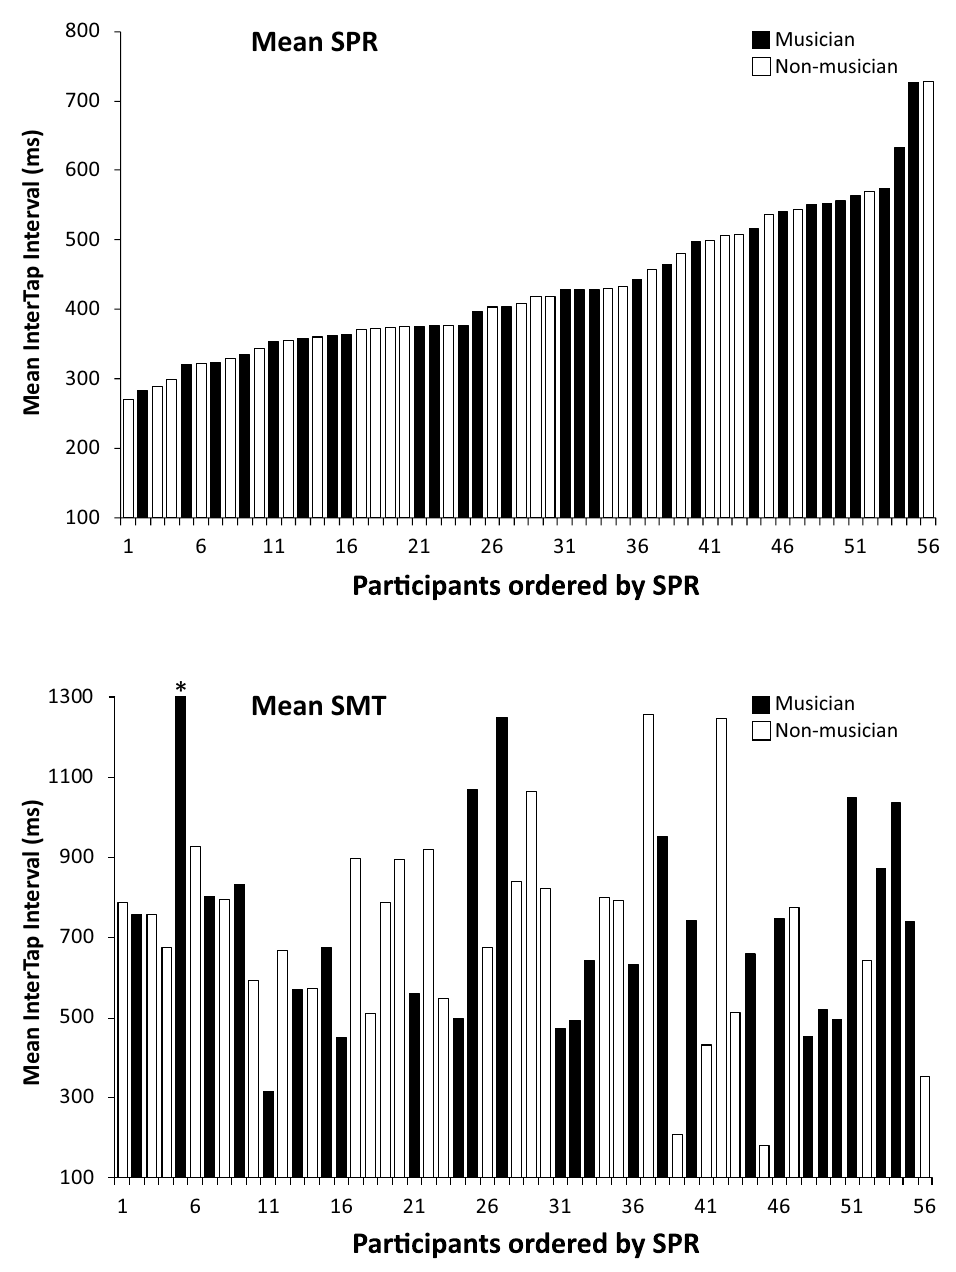
Figure 1. Mean Intertap interval in Solo production rate (SPR) task (top) and SMT task (bottom). Participants ordered left to right by increasing SPR value (top and bottom). Each bar represents one participant. Asterisk indicates an SMT value more than 3 standard deviations above the grand mean (= 2102